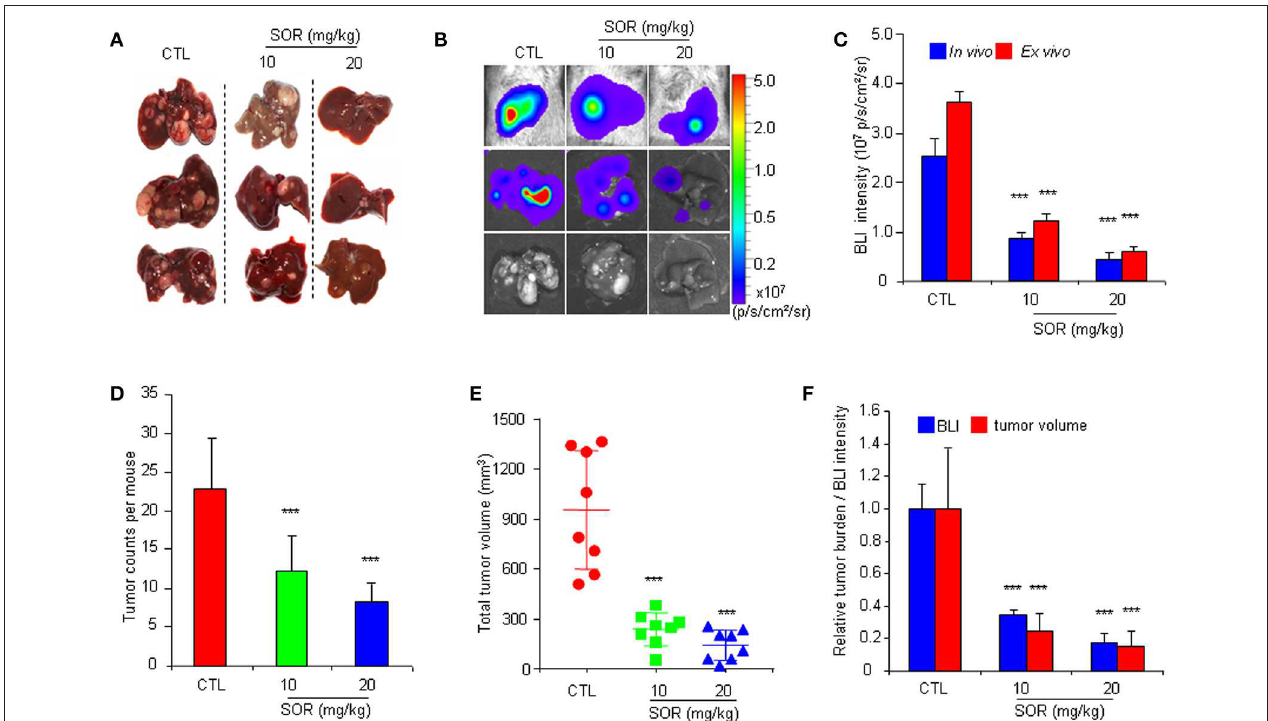
FIGURE 3 | Comparative analysis of the effect of sorafenib on BLI intensity and the actual anti-HCC effects in HCR mice. (A) Gross appearances of representative livers with tumor nodules after 4 weeks of sorafenib (SOR) or vehicle solution (CTL) treatment. (B) Photograph showing the final in vivo and ex vivo BLI intensity and liver tumors upon autopsy. (C) The in vivo and ex vivo BLI intensity in mouse groups after sorafenib treatment ( n = 8). (D) Group tumor burdens are presented based on the tumor count in each mouse ( n = 8). (E) Group tumor burdens are presented based on the total tumor volume in individual mice ( n = 8). (F) Relative tumor burden/BLI intensity in mice in groups that underwent vehicle (CTL) or sorafenib (SOR) treatment ( n = 8). *** P < 0.001 vs.